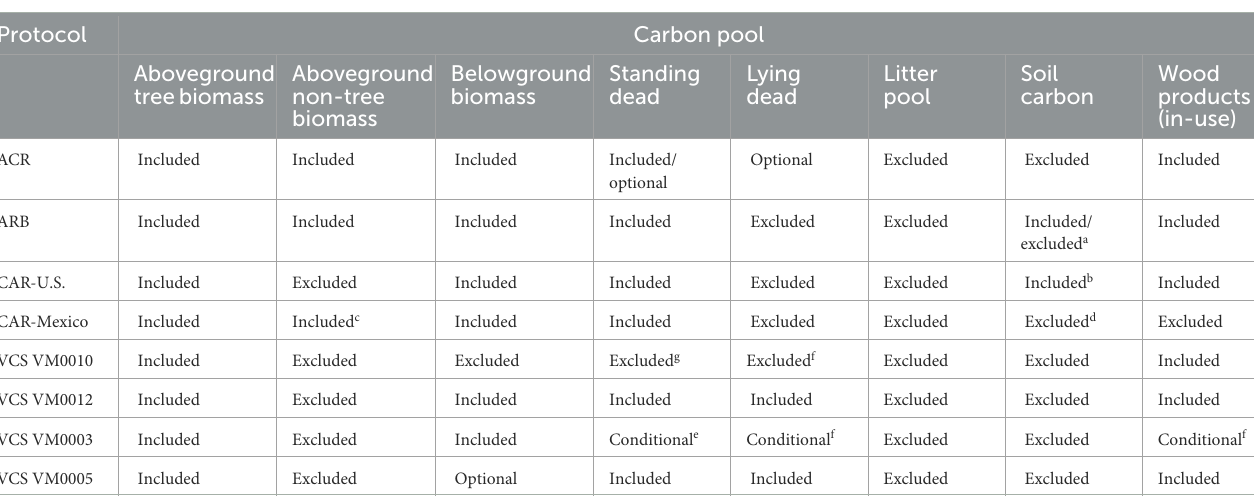
TABLE 5 Summary of carbon pools in IFM